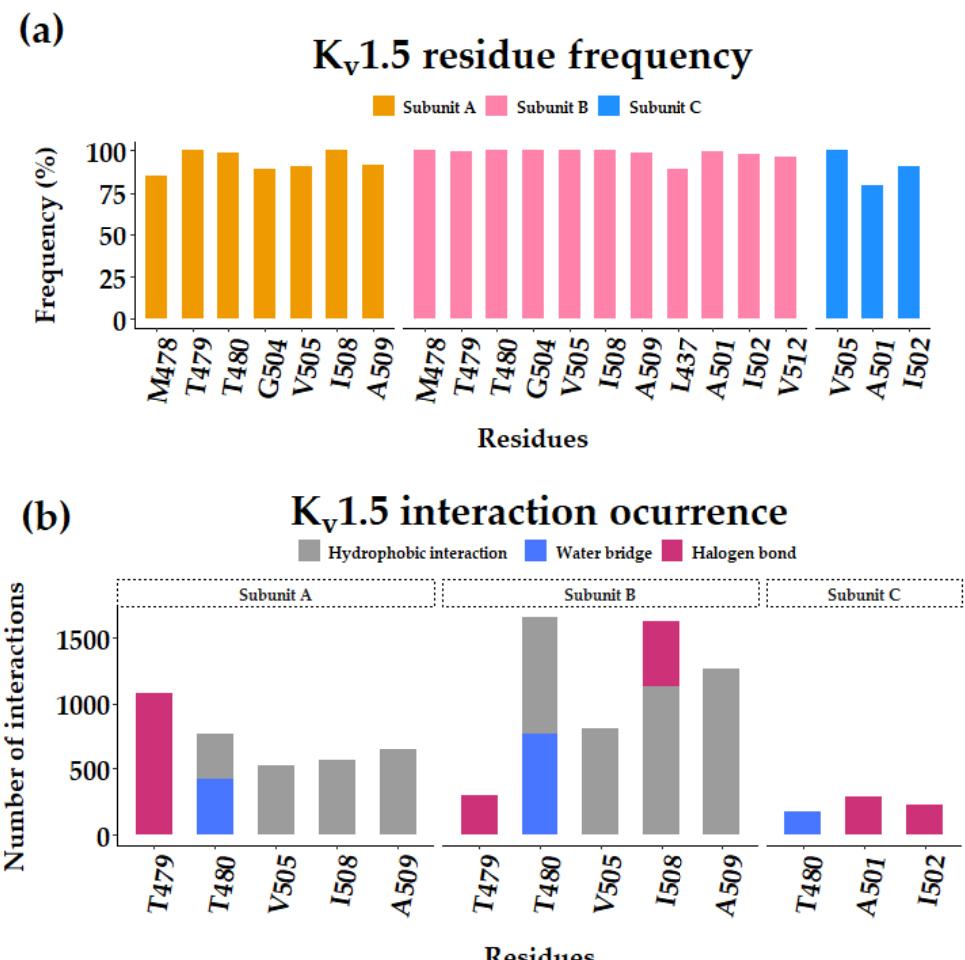
Figure 2. Flecainide interactions in K v 1.5 along MD simulations . The residue contacts and interactions were computed along the three 100 ns MD simulations’ replicas concatenated. ( a ) Residues in contact within 5Å of flecainide with a frequency of ≥70%. ( b ) Residues interacting with flecainide and the nature of such interactions predicted using PLIP software. Only the residues with number of interactions ≥ 20 % of the maximum value of its type are considered.